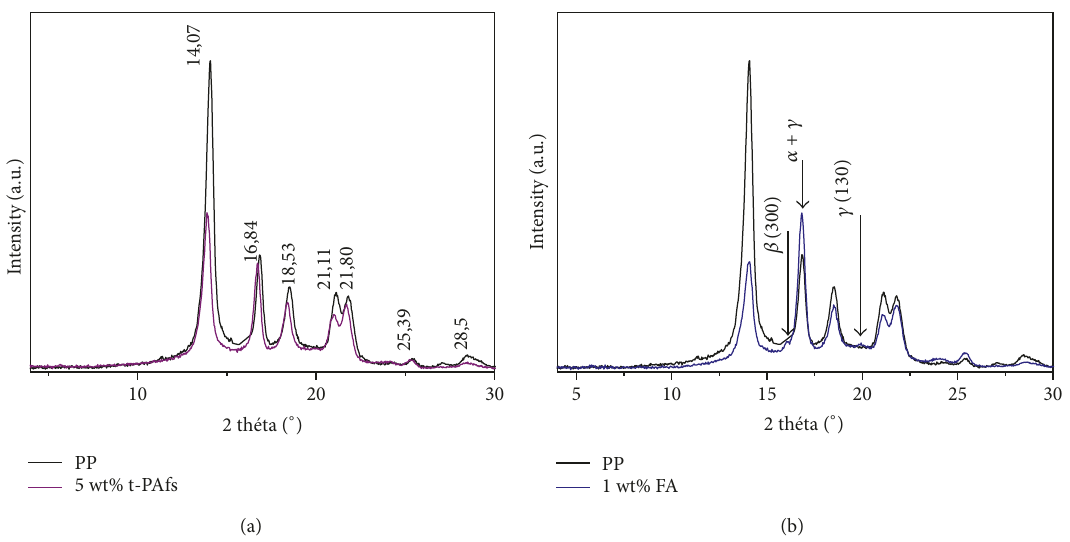
Figure 4: WAXS patterns of (a) 5wt% t-PAfs/PP composite and (b) 1wt% FA/PP crosslinked PP.